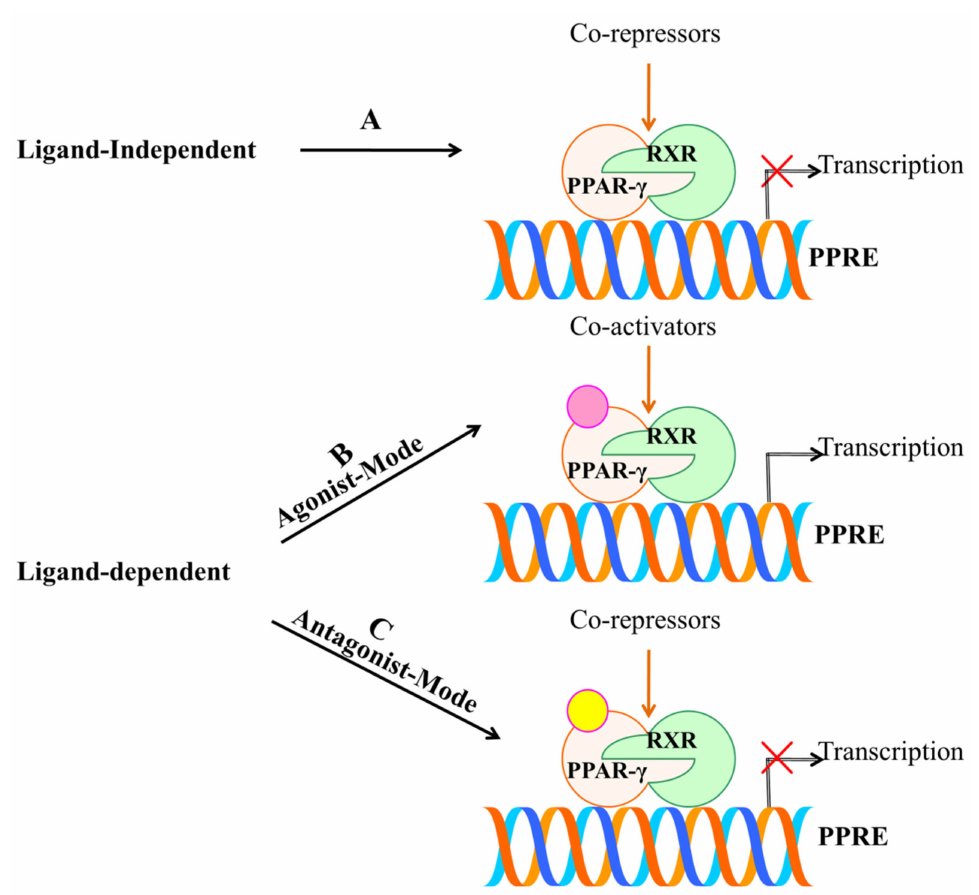
Figure 5. Schematic representation of activation of PPAR- γ receptor through ligand-dependent or -independent mechanisms. ( A ) Ligand-independent mechanism does not involve the active participation of ligand, and co-repressors bind to unliganded PPAR- γ , which repress the gene expression by chromatin remodeling. ( B ) Agonist mode of action involves the binding of ligand to LBD of PPAR- γ with the help of co-activators, which further leads to transcription of targeted genes. ( C ) Antagonist mode of action also involves the binding of ligand without leading to transactivation activity, due to the presence of